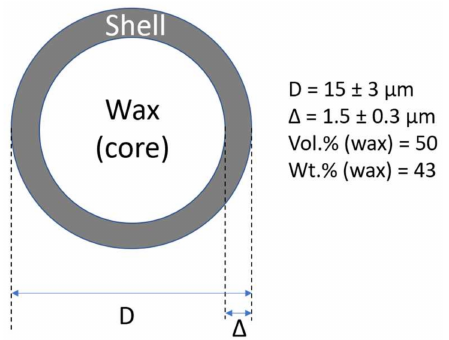
Figure 1. Typical shape and dimensions of synthesized microcapsules